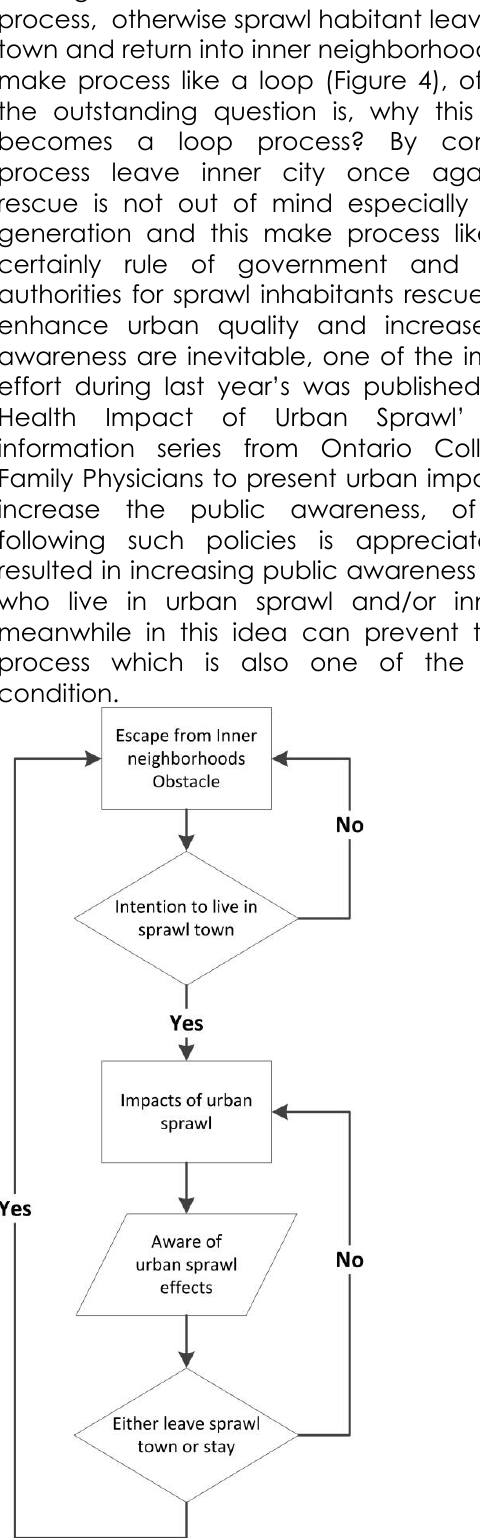
Figure 3. Flowchart of resident rescue (Illustration by author).